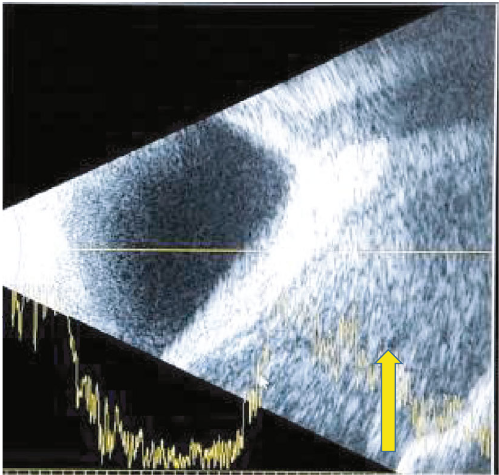
Figure 4: USG B-scan: homogenous mass distorting the globe inferiorly (as shown by an arrow) in the left eye.